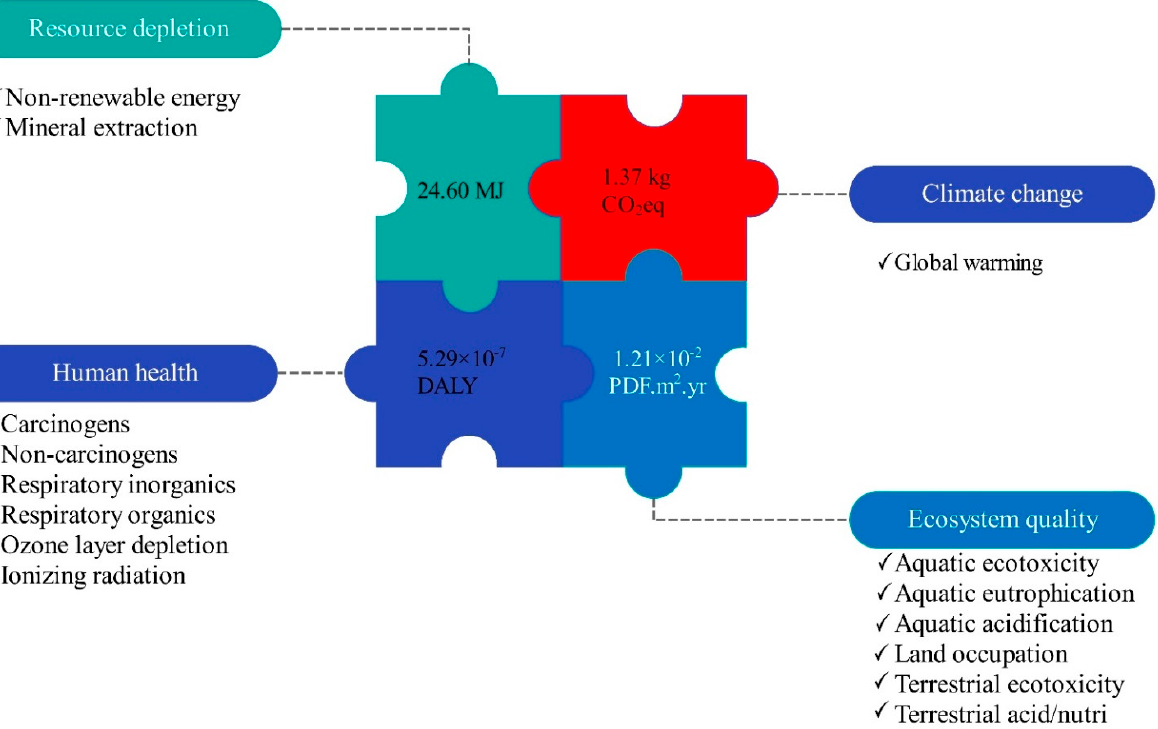
Figure 5. Contribution of consumed inputs to the environmental impact of the olive kernel oil production system. Foods 2021 , 10 , x FOR PEER REVIEW